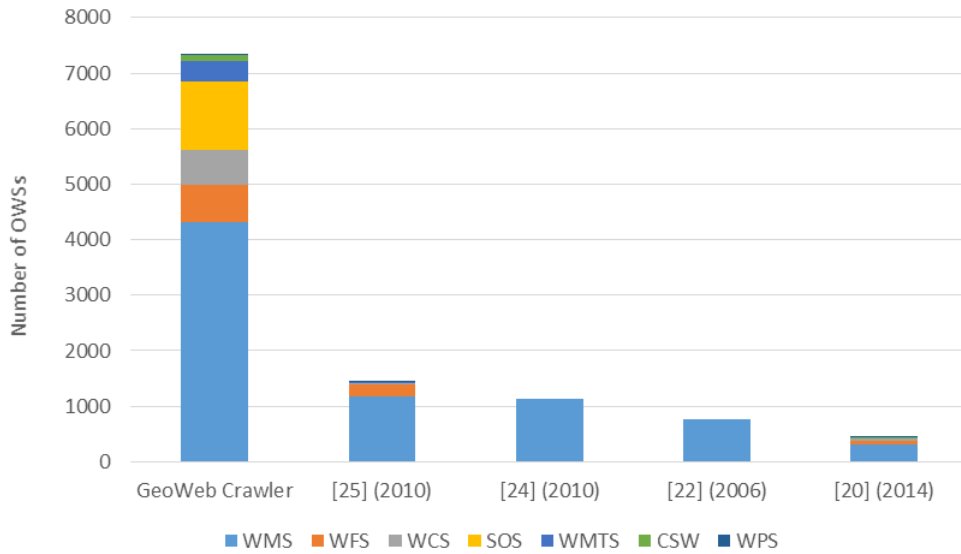
Figure 9. Number of OWSs comparison between GeoWeb Crawler and existing approaches.